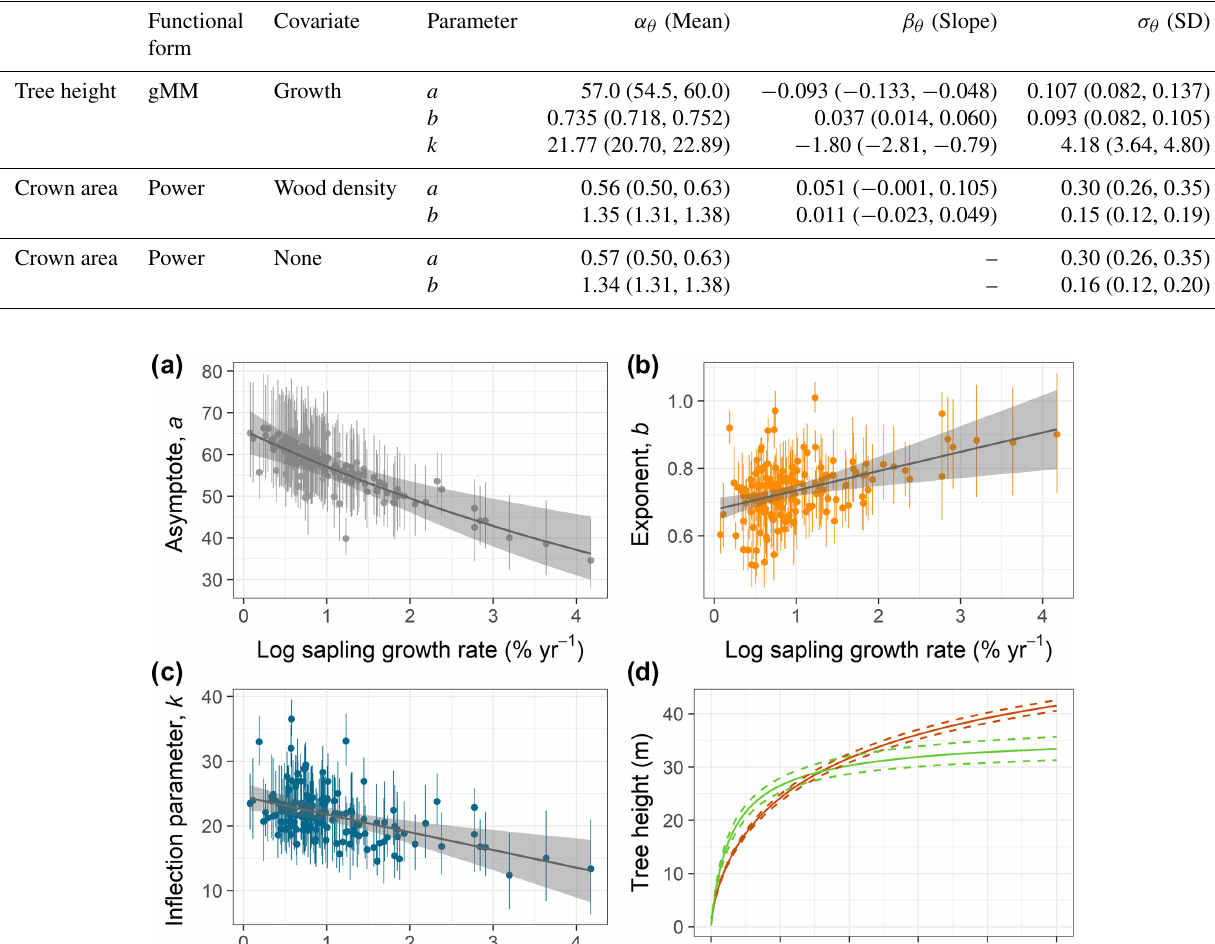
average power model were 12.3 % larger than those